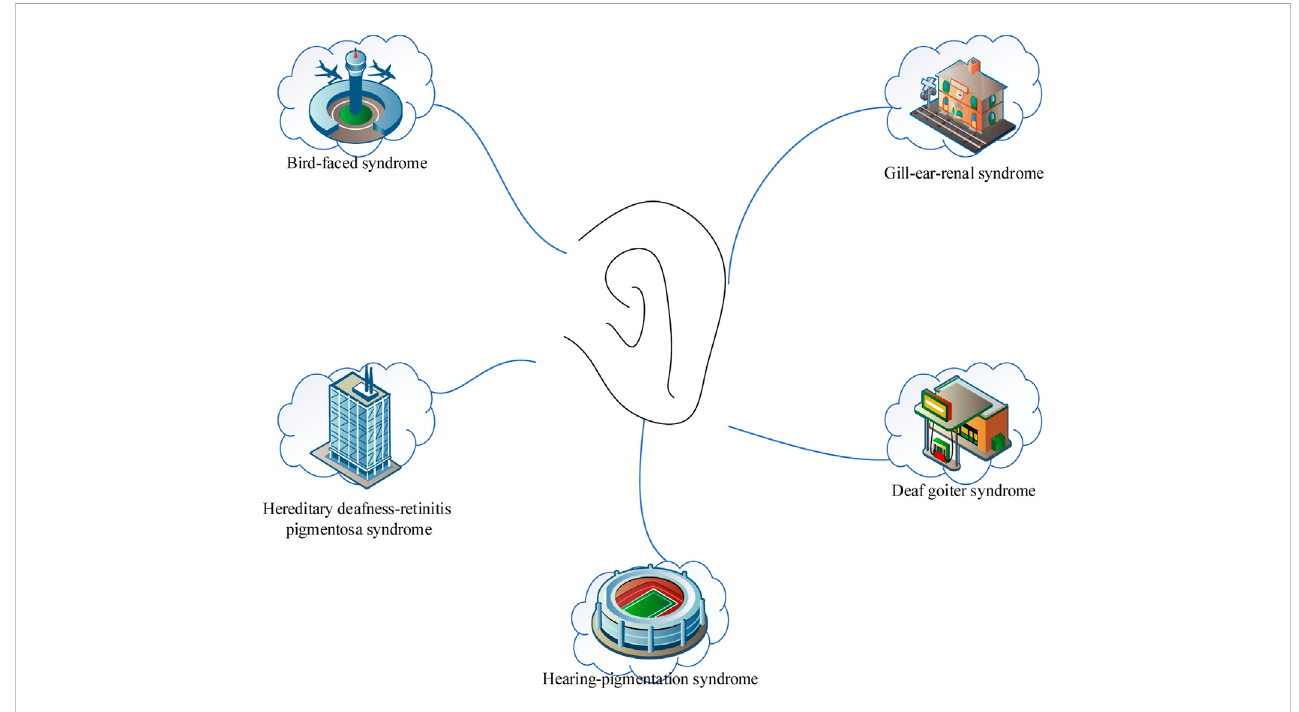
FIGURE 1 Common comprehensive